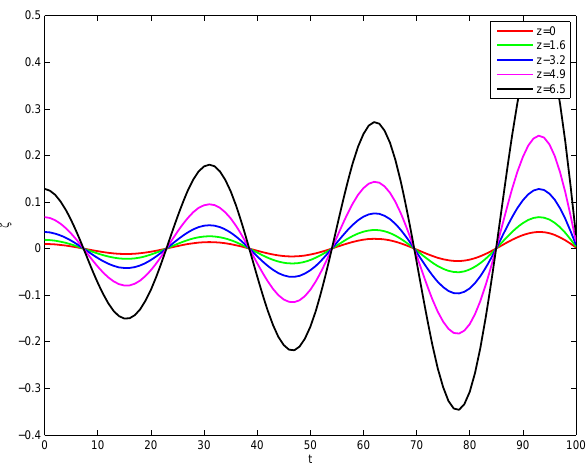
Figure 2. A cross section of the perturbation in ρ at x =